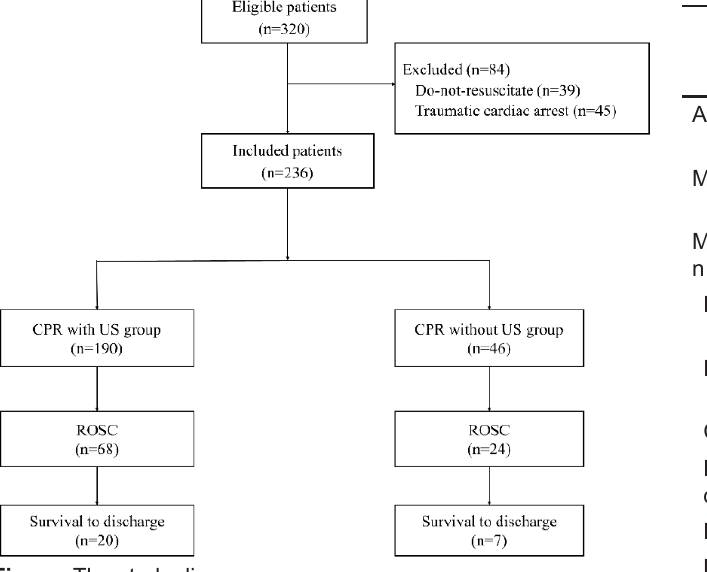
Figure. The study diagram. CPR, cardiopulmonary resuscitation; ROSC, return of spontaneous circulation; US, ultrasonography.